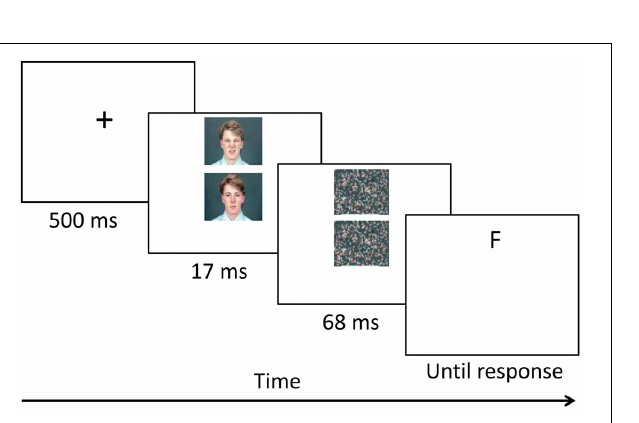
FIGURE 2 | Sequence of events in a subliminal dot-probe trial.